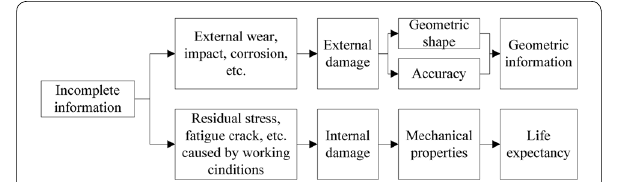
Figure 2 Incomplete information of used parts